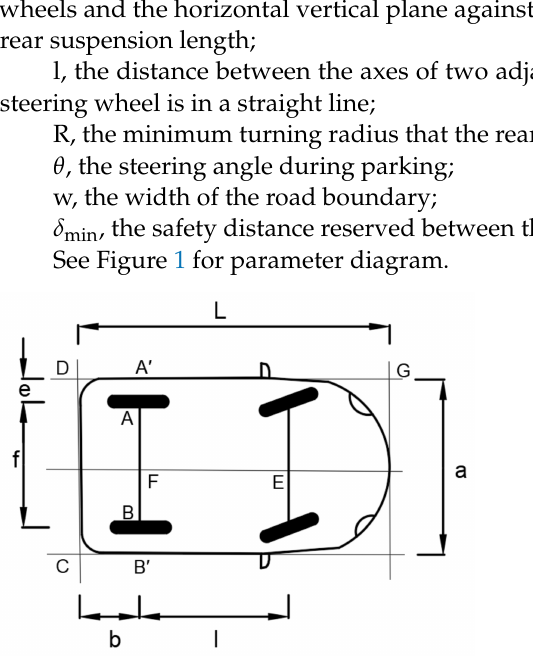
Figure 1. Example of vehicle dynamics